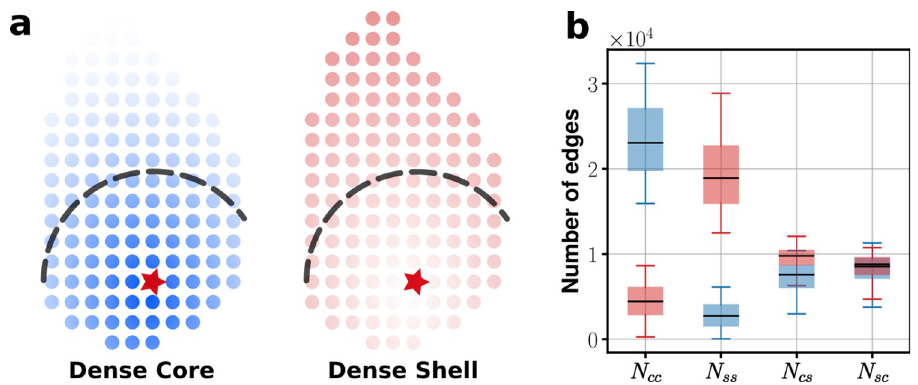
Fig 4. Schematic illustration of two different node configurations in (a) and the number of efferent connections within two compartments [core-to-core ( N ) and shell-to-shell ( N )] and those across them [core-to-shell ( N ) cc ss cs and shell-to-core ( N )]. The red stars in (a) mark the central position ( p c , q c ) of the SCN. The blue (red) color sc represents the case of dense core (shell) and the different levels of shade represent the corresponding values of degree. The data shown in (b) is for the cases when k in is positively correlated with k out (blue: core dense; red: shell dense). The subdivision ‘core’ is the area occupied by all the nodes that are within 245 μm from ( p c , q c ); the boundary between two subdivisions is marked by a dashed line. The color shades schematically illustrate the size of k total (see S1 Text for further detail).